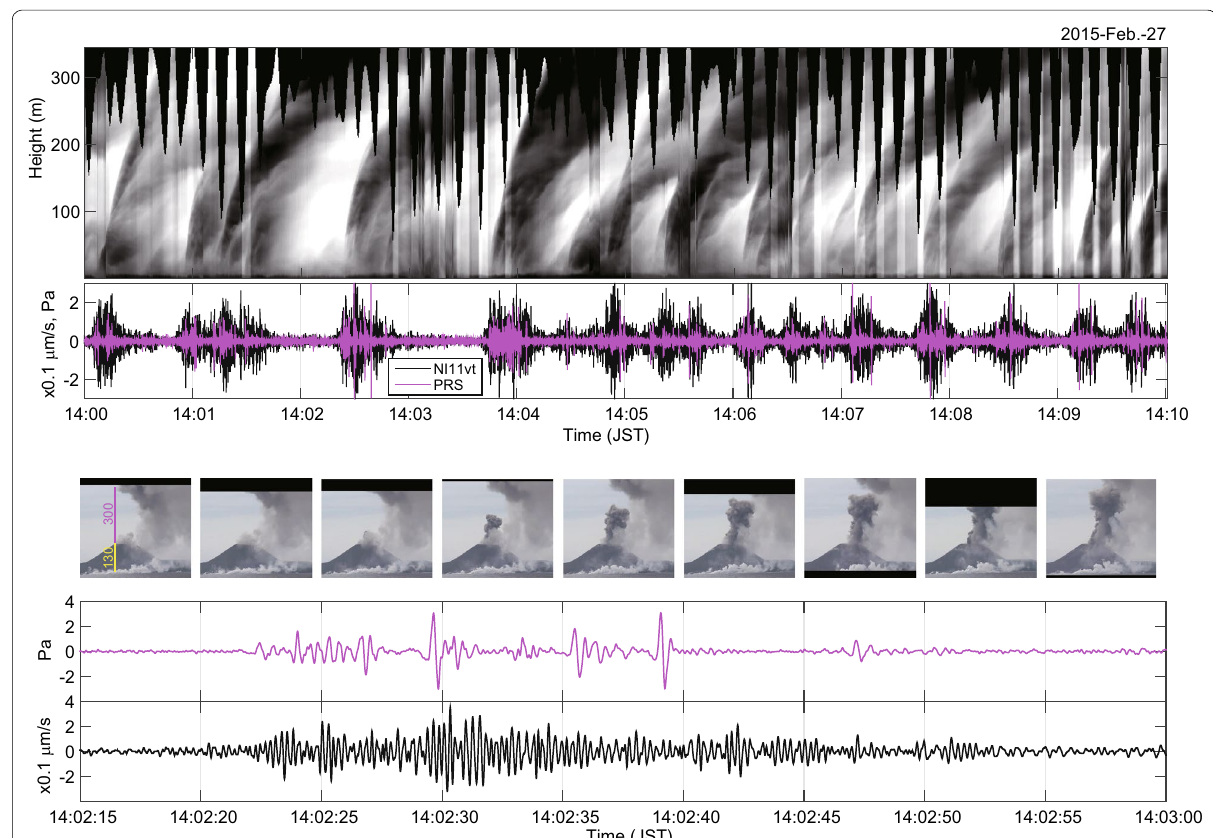
Fig. 3 Comparison of LT-OBS and infrasonic records with the plume flow from the crater (upper) and photographs of the plume emission from Nishinoshima volcano (lower). Upper: detection of a plume above Nishinoshima using video recorded on the R/V Kairei. Images just above the cra- ter were retrieved, and brightness was averaged on the images. The ascending plume corresponds to a trajectory of black images toward the upper right. Pink and black curves indicate infrasonic data with a filter of 1–7 Hz and vertical component of seismic records in the NI11 with a bandpass of 4–8 Hz. Considering travels times, infrasonic records and LT-OBS records have delays of 17.7 and 7 s, respectively. A packet of seismic events is related to a series of plume emissions. Lower: pictures at an interval of 5 s retrieved from the video are shown with infrasonic and LT-OBS